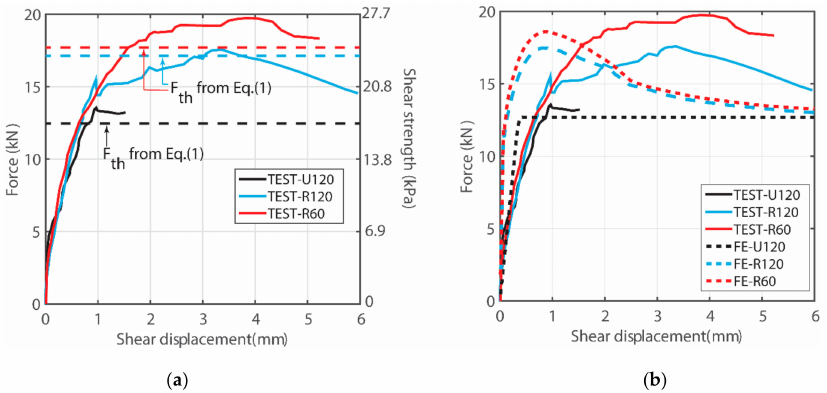
Figure 7. Shear force vs. shear displacement for: ( a ) Experimental and theoretical; ( b ) Experimental and FE